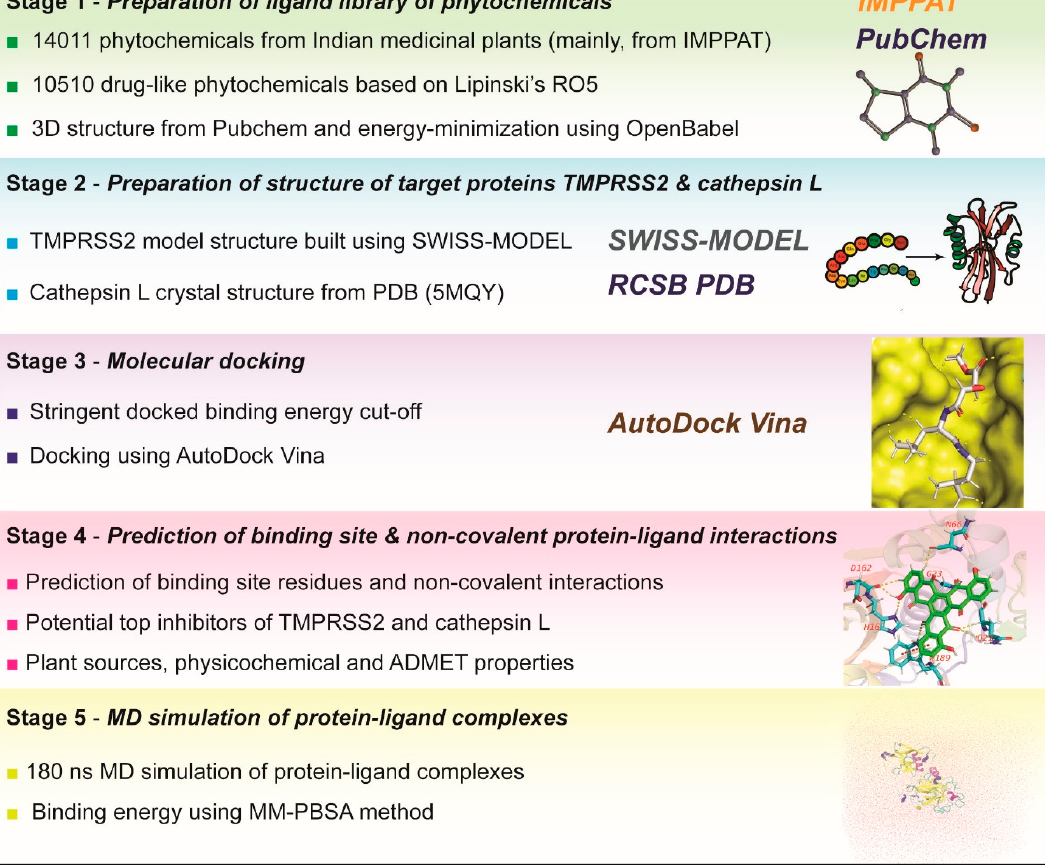
Figure 1. Virtual screening workflow to identify potential phytochemical inhibitors of human proteases TMPRSS2 and cathepsin L.